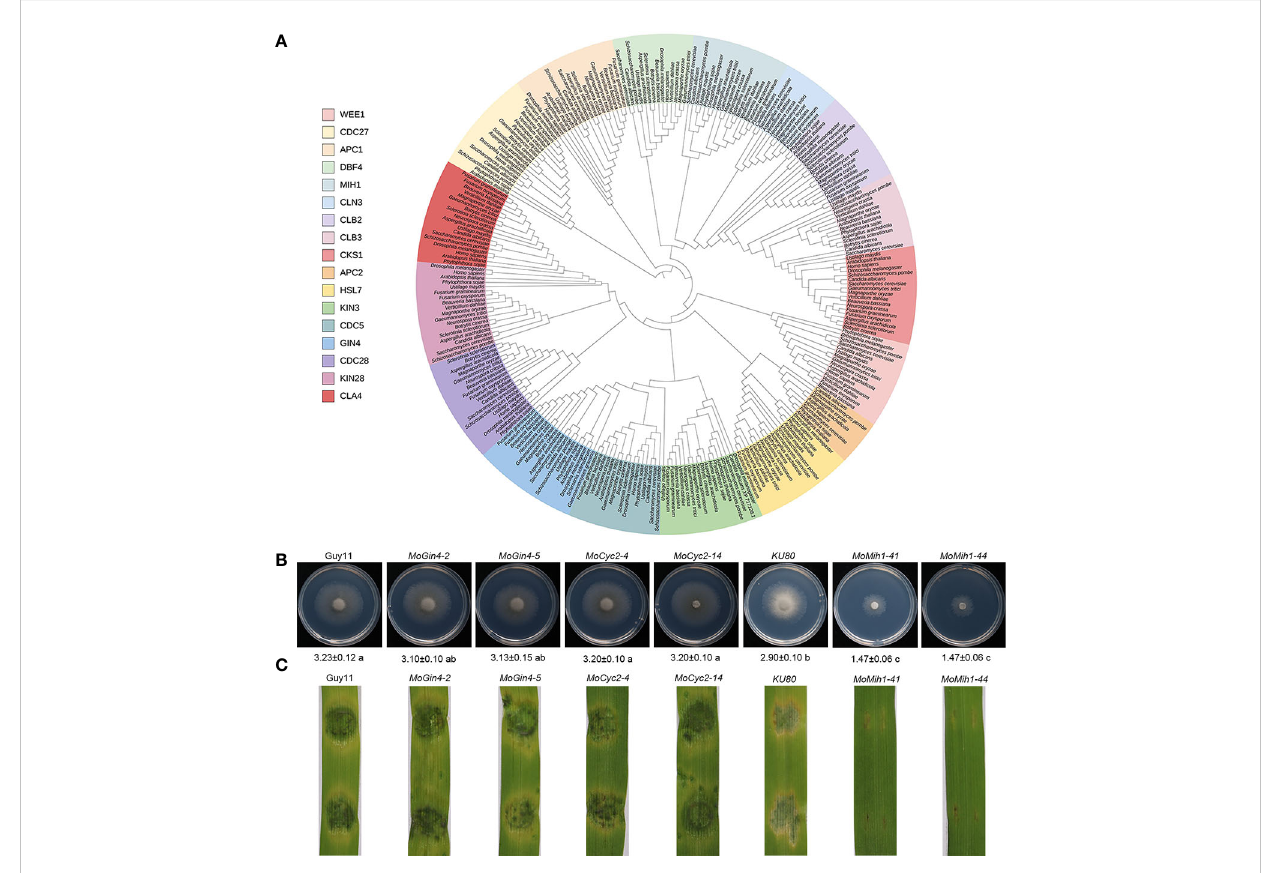
FIGURE 1 The orthologues of cell cycle and morphogenetic proteins in M. oryzae . (A) Phylogenetic analysis and classi fi cation of cell cycle and morphogenetic related genes in diverse species. IQ-TREE 2 was used to establish a phylogenetic tree based on the full length of these proteins using the maximum likelihood method. (B) The mycelial growth of the tested strains. The colony diameters of the tested strains were assayed on MM medium at 5 dpi. (C) The pathogenic assay of the tested strains. Mycelial plugs of the tested strains were inoculated on 7-day-old barley leaves, and the diseased leaves were recorded at 5